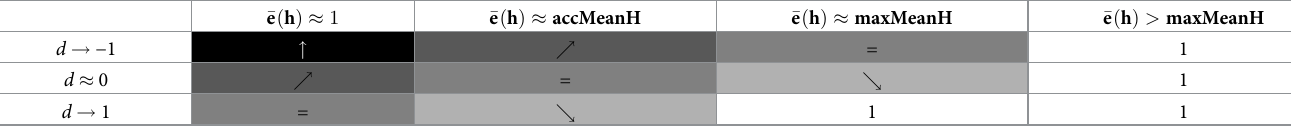
Table 1. Changes on the following chunk sized according to d and � e ð h Þ